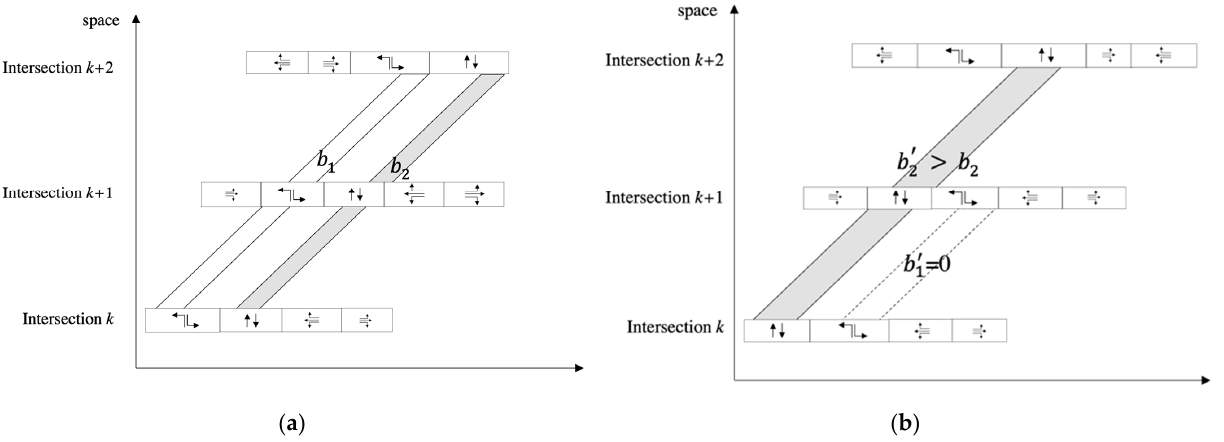
Figure 5. Demonstration of the change of bandwidth after optimized phase sequence and offset: ( a ) The bandwidth under the original phase sequence; ( b ) the bandwidth after changing the phase se ‐ quence.